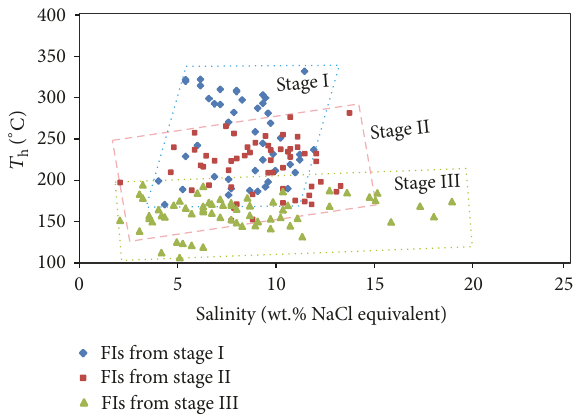
Figure 12: Total homogenization temperatures versus salinities diagram for the three hydrothermal stages showing fluid evolution of the Nanmushu Zn-Pb